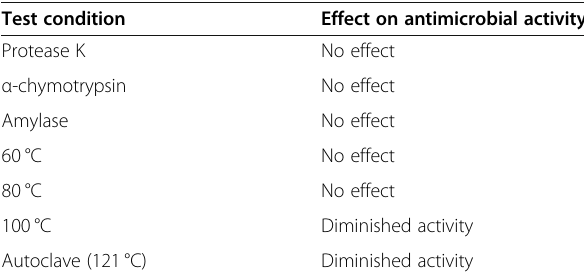
Table 1 Characterization of the total antimicrobial activity of Streptomyces sp. MS. 10